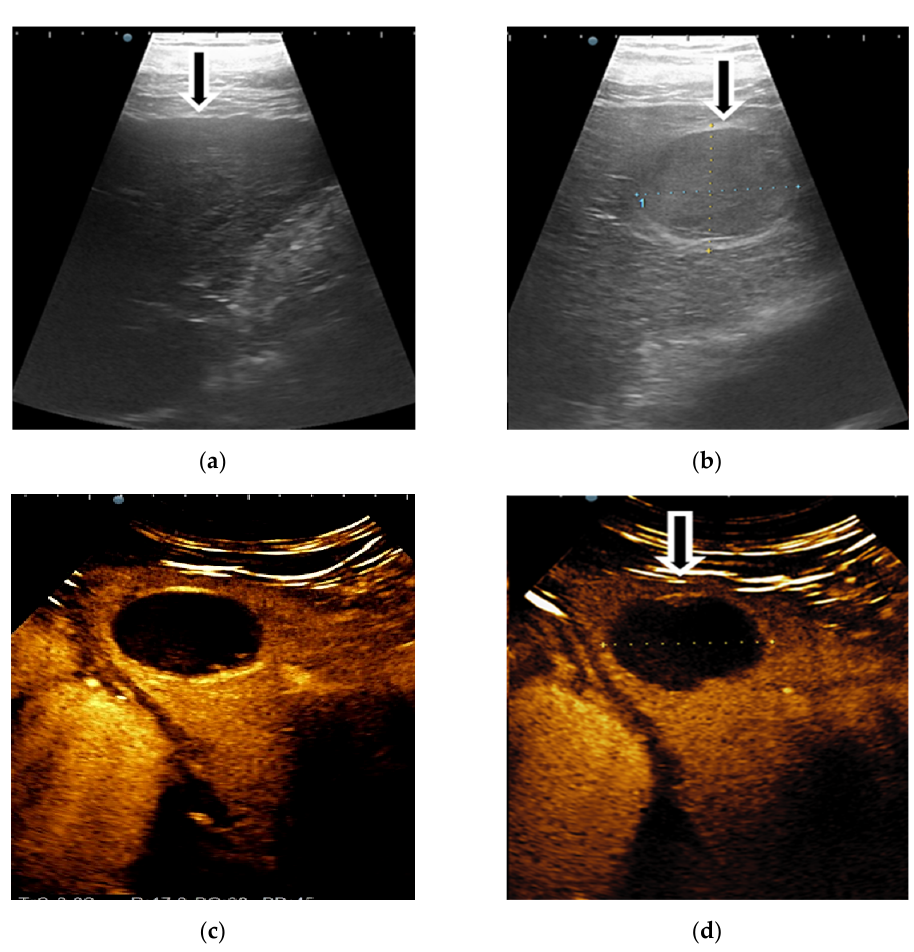
Figure 4. Illustration of LI-RADS-1 liver lesion in a patient with alcoholic liver cirrhosis. B-mode ultrasound using linear probe shows an inhomogeneous liver with nodular liver surface ( a ). In the right liver lobe, subcapsular, a well delimited, inhomogeneous hypoechoic liver lesion ( b ) that is nonenhancing on CEUS in all vascular phases ( c , d ). The final diagnosis was a complex cyst.